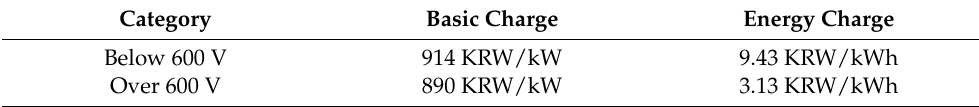
Table 1. Fixed network use cost ( λ F